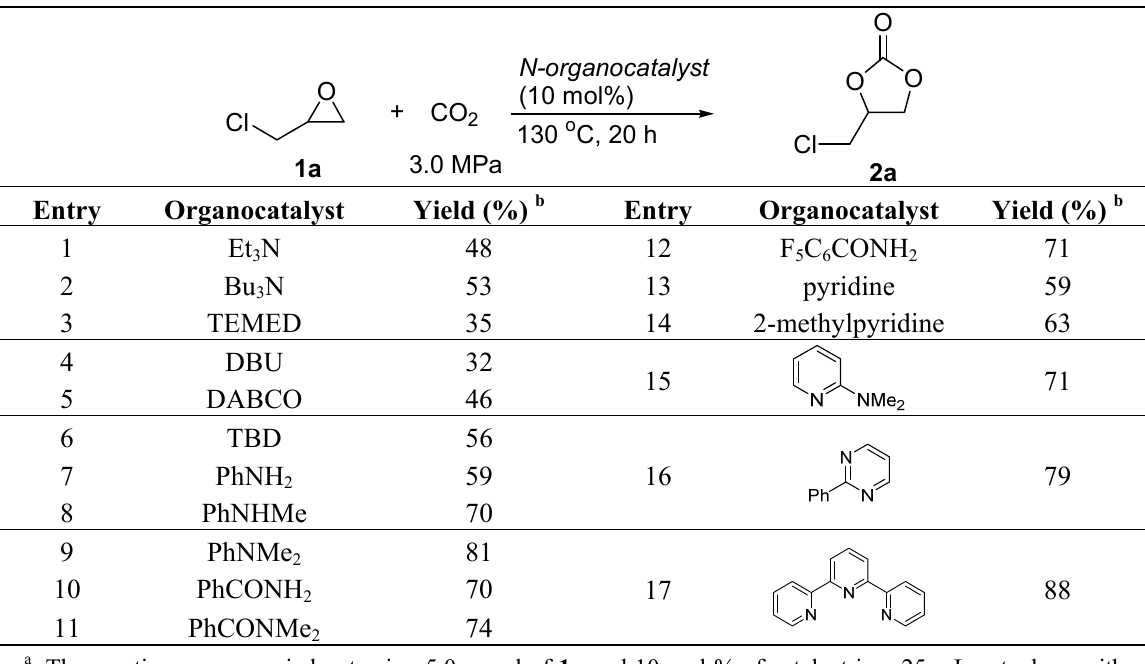
Table 1. Catalytic activity of nitrogen-containing compounds in the coupling